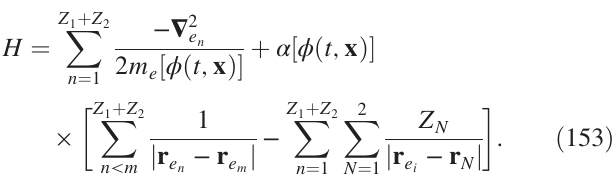
(155) driving the optimum sensitivity projections in Figs. 10 and 11 for the bulk (B) and stack (S) configurations. To estimate vibrational matrix elements, we make use of Eqs. (47) – (50) and the parametric estimates of Eq. (53). For δ H 1